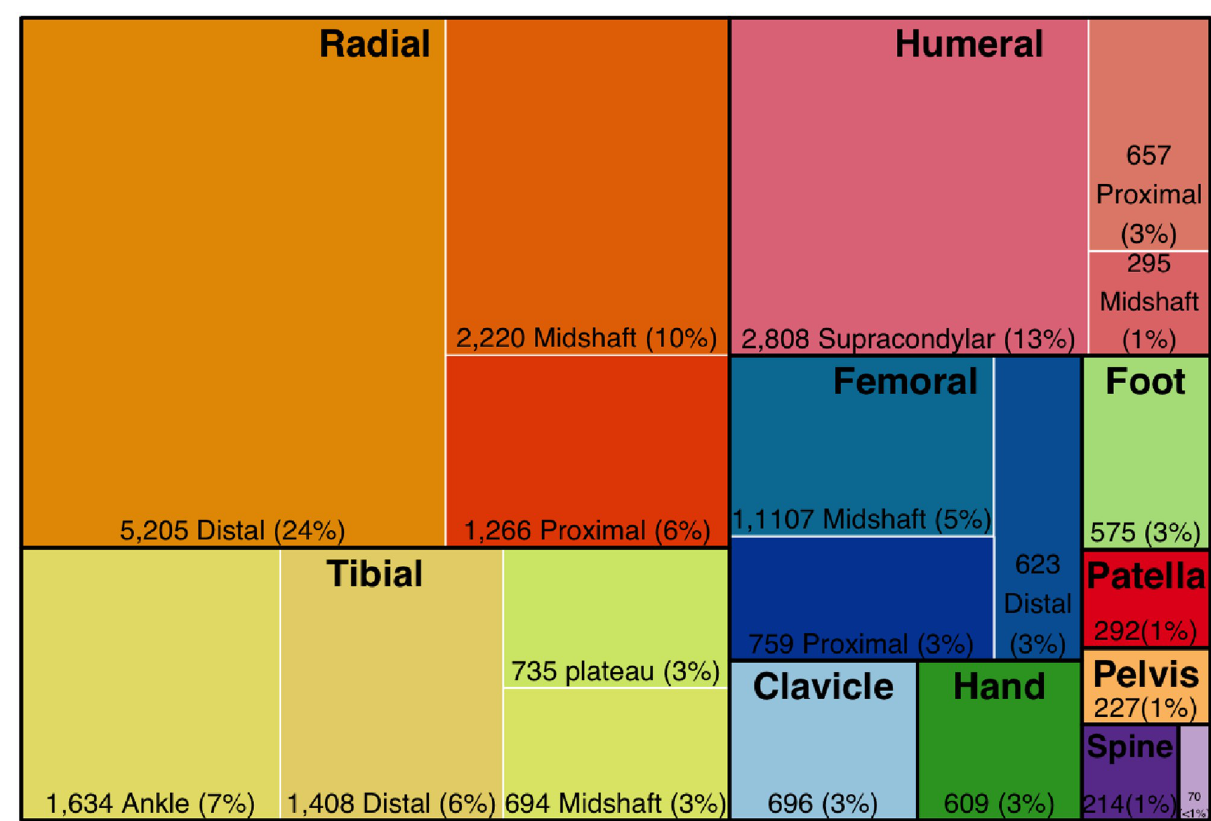
Fig 2. Fracture characteristics (groups are bone names, sub-groups are fracture locations, n = 23,014). 720 missing.